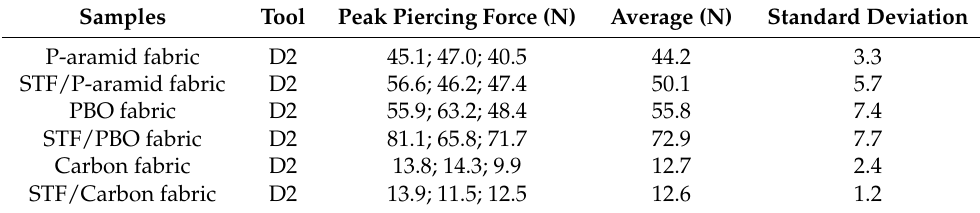
Table 1. Peak piercing force of different fabrics when punctured by D2 knife. Samples